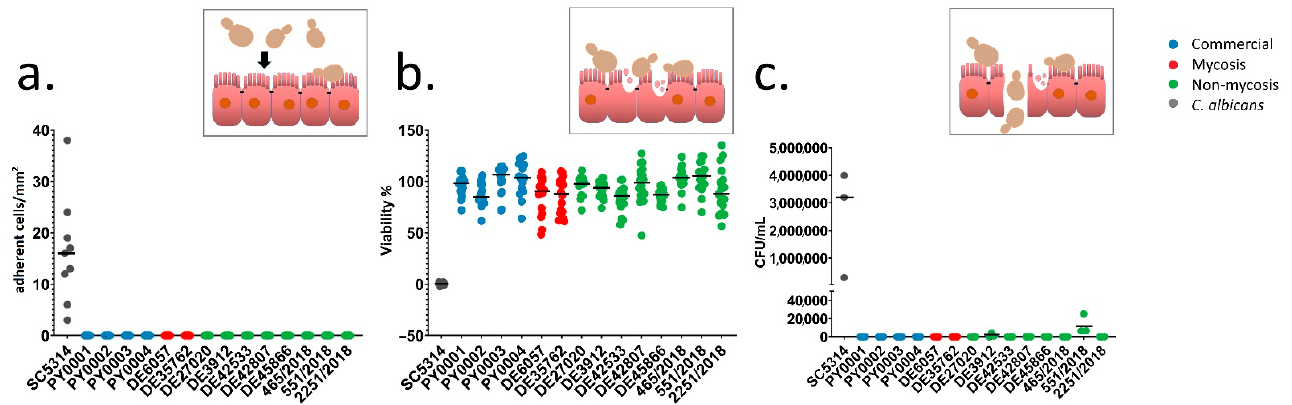
Figure 3. Interactions with epithelial model: adherence, damage, and transmigration. Inset pictures depict short explana- tions of the yeast-epithelium interactions (yeast cell sizes are exaggerated for better viewability). Individual data points are shown, colors represent yeast groups. Horizontal lines represent mean. ( a ) Adherence assay. Adherent yeast cells observed on Caco-2 epithelial model per mm 2 . ( b ) Damage assay. Caco-2 epithelial model relative viability (in %) after co-incubation with yeasts, based on MTT-assay. ( c ) Transwell assay. CFU/mL values in lower compartment of the Transwell plates are shown after co-incubating yeasts in the upper compartment with Caco-2 epithelial model on Transwell inserts for 144